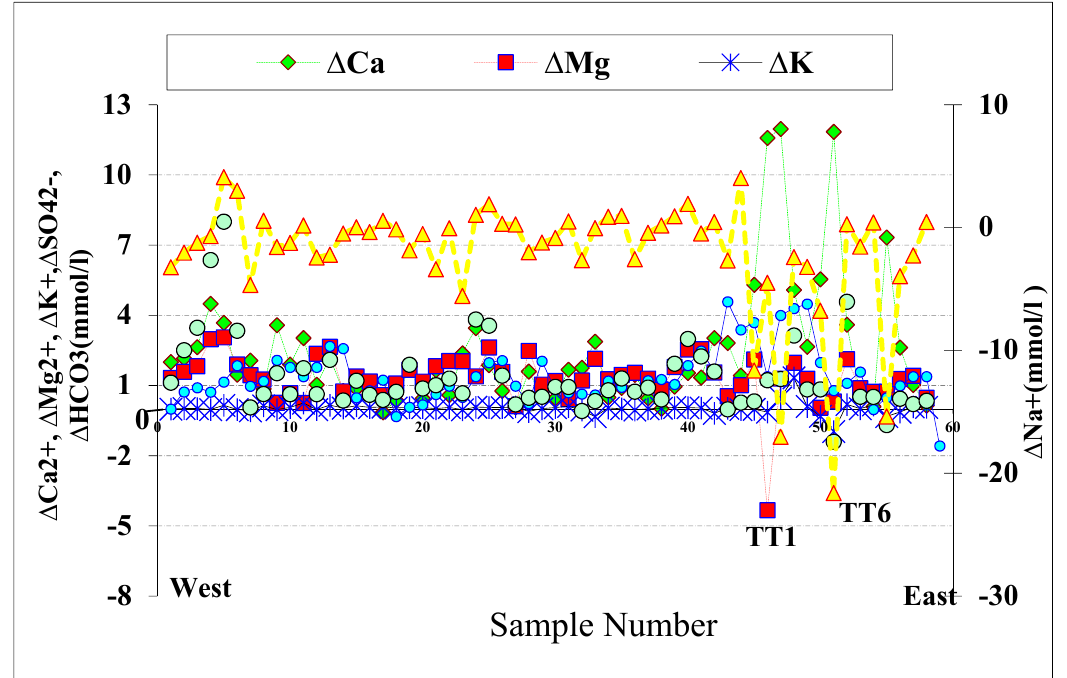
Figure 12. Diagram of ionic delta for all analyzed samples.